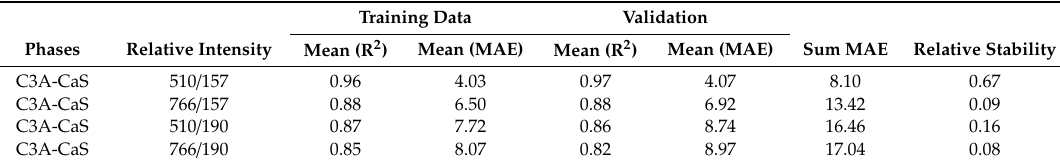
Table 7. Evaluation of the coe ffi cient of determination (R 2 ) and mean absolute error (MAE) for the prediction and validation between the phase content and relative intensity of the Raman peaks and phase content for C3A-CaS.